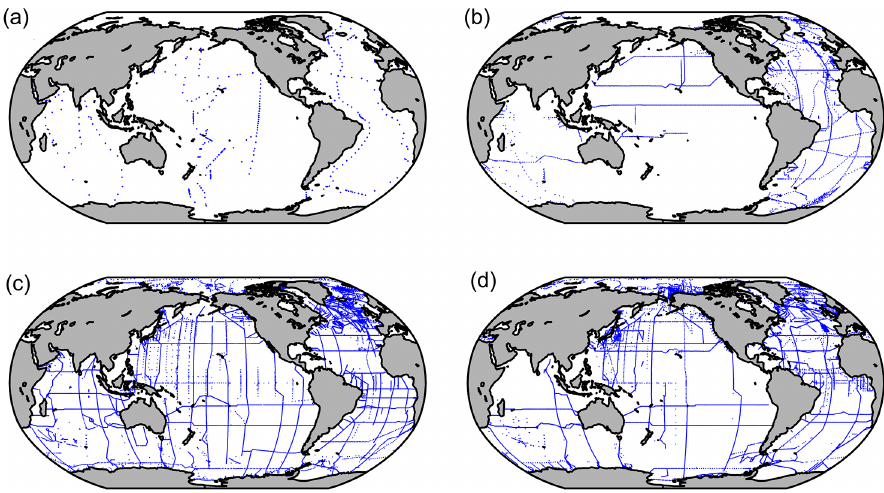
Figure 6. Station locations in the GLODAPv2 data product for data obtained during (a) the 1970s, (b) the 1980s, (c) the 1990s, and (d) 2000s and beyond.